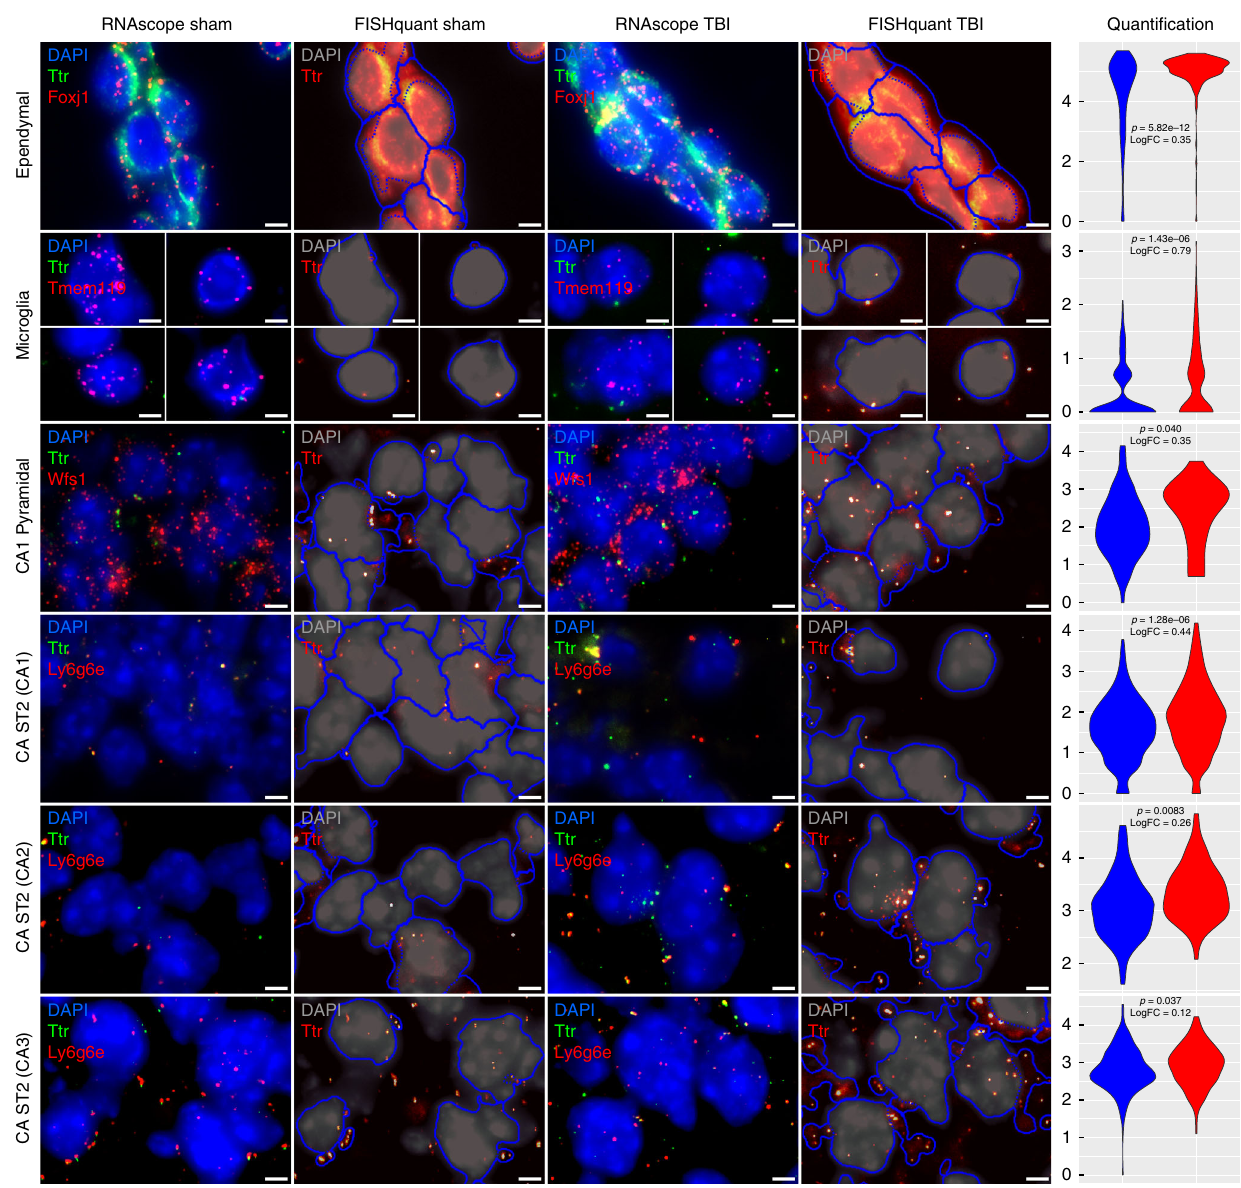
Fig. 8 Validation of increased Ttr expression post-TBI using RNAscope in situ hybridization. Representative fl uorescent microphotographs for Sham and TBI showing Ttr along with cell type markers with DAPI in the background. The RNAscope images for Sham ( fi rst column) and TBI (third column) display cell colocalization of Ttr (green) and the corresponding cell marker gene (red). The corresponding FISH-quant images for Sham (second column) and TBI (fourth column) show the automated cell segmentation (blue) overlayed on the 2D maximal projection of the DAPI z-stack images (gray) with Ttr (green in the RNAscope images) indicated in bright dots. The quanti fi cation of Ttr expression is shown in the violin plots (5th column) with Sham in blue and TBI in red. Only cells which meet a certain count threshold for the cell type marker gene are considered the appropriate cell type and used for Ttr quanti fi cation (details in Methods). The ln(counts per cell) of Ttr is shown on the y -axis with the p -value from a bimodal likelihood ratio test and log fold change (logFC) between TBI and Sham samples indicated. These fi gures have been zoomed in 5x from the original form to show high magni fi cation detail of a few cells to more easily demonstrate colocalization between Ttr and cell type markers. Lower magni fi cation photos which indicate the region which was magni fi ed are provided in Supplementary Fig. 12. Scale bars are 4 µ m. Sample size was n = 8